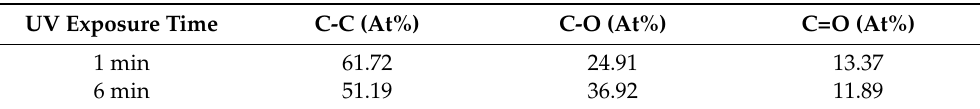
Table 1. Atomic concentrations of variously bound carbons on the surface of the 1 min and 6 min UV-exposed hybrid films.